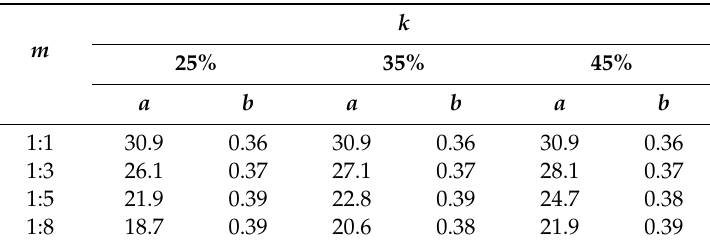
Table 3. Fitting results.